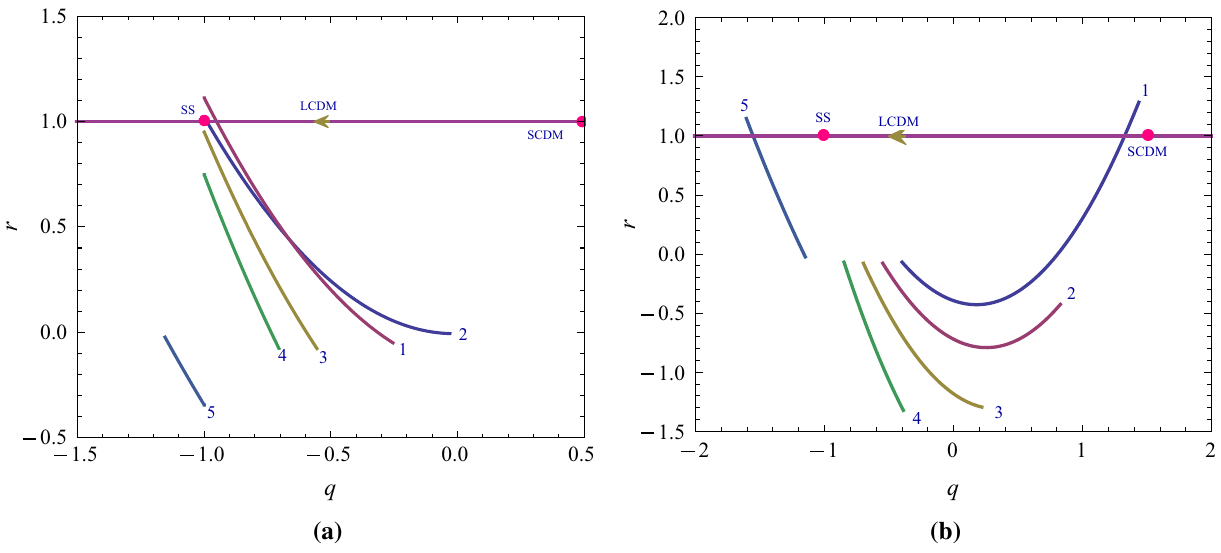
Fig. 3 The r − q trajectories has been plotted in the figure. We have taken H 0 = 10 and t 0 = 1 to plot the trajectories. The figure a is plot- ted for negative value of interaction rate (cid:10) = − 0 . 1 and the figure b is plotted for positive value of interaction rate (cid:10) = 0 . 01. In figure ( a ),